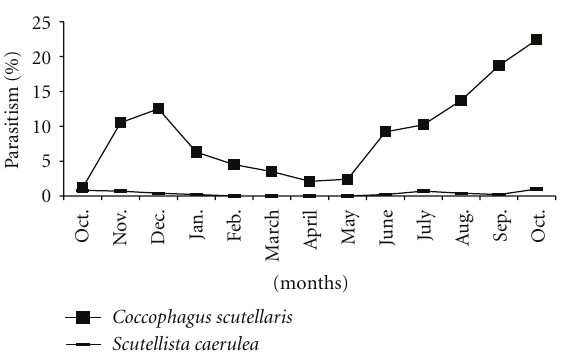
Figure 9: Percent parasitism of Coccophagus scutellaris and other associated parasitoids of Pulvinaria psidii on mango in Ismailia governorate after releasing during 2009-2010.